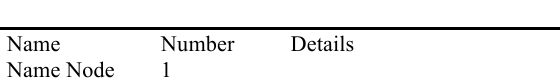
Table 1. Single machine